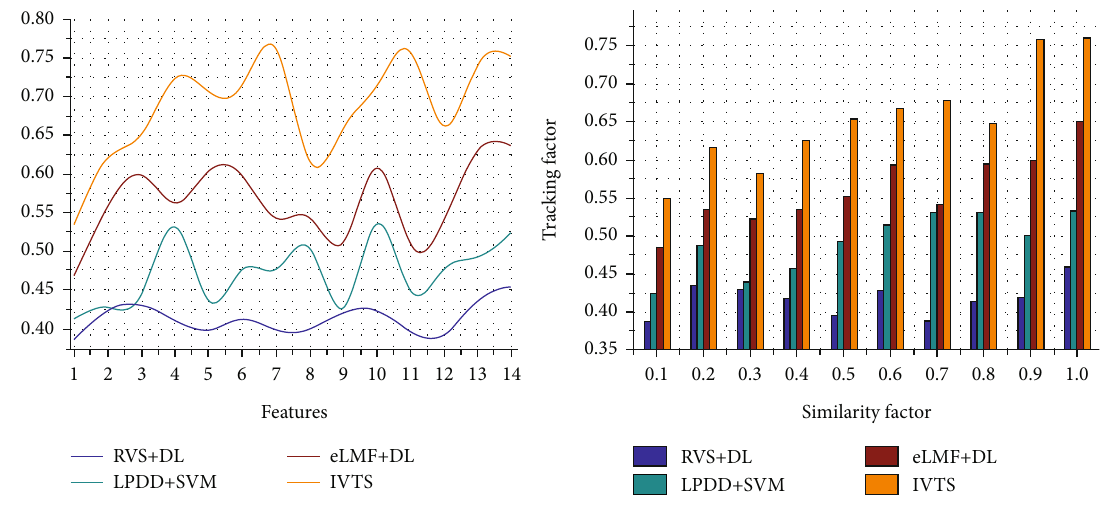
Figure 9: Tracking factor analysis.